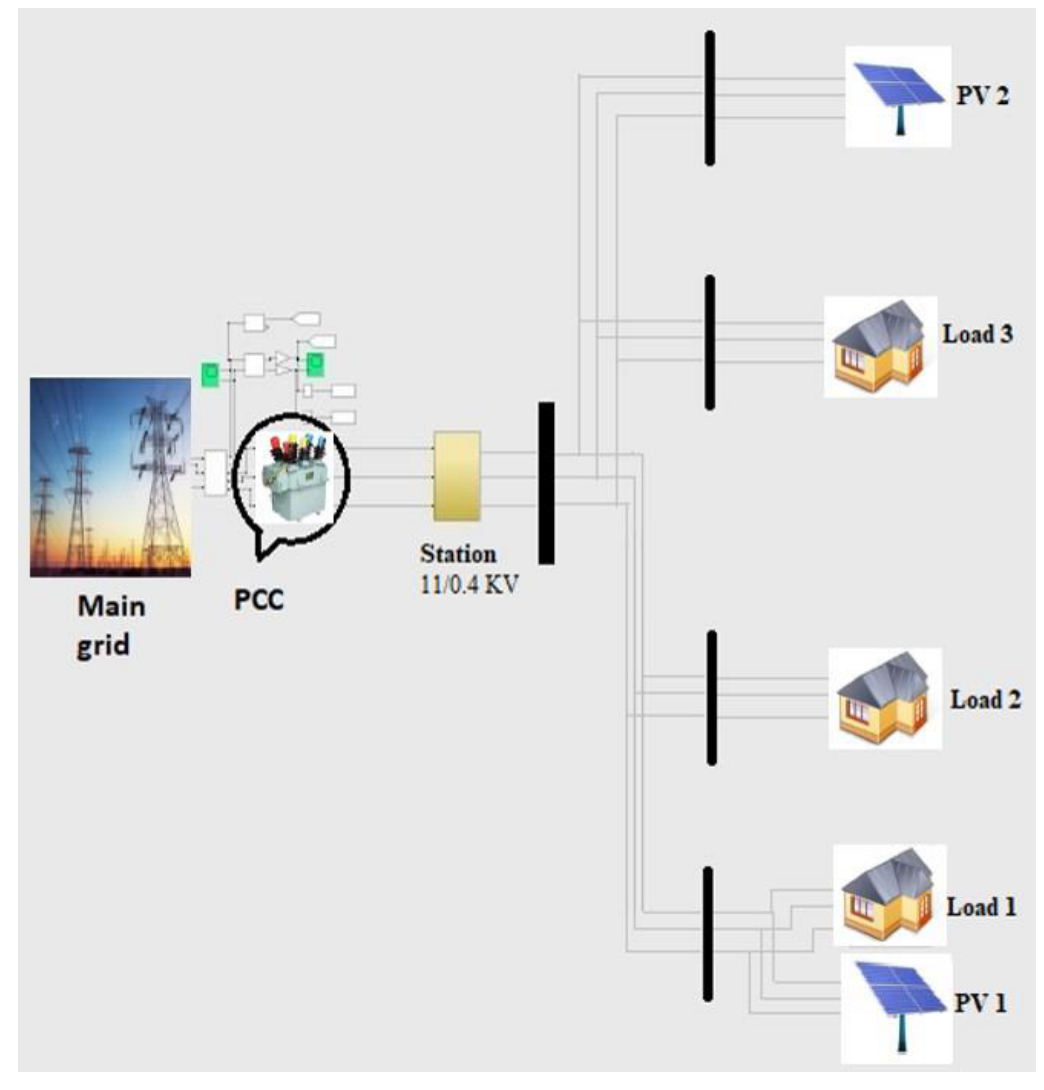
Figure 5. MG 1 model in MATLAB.